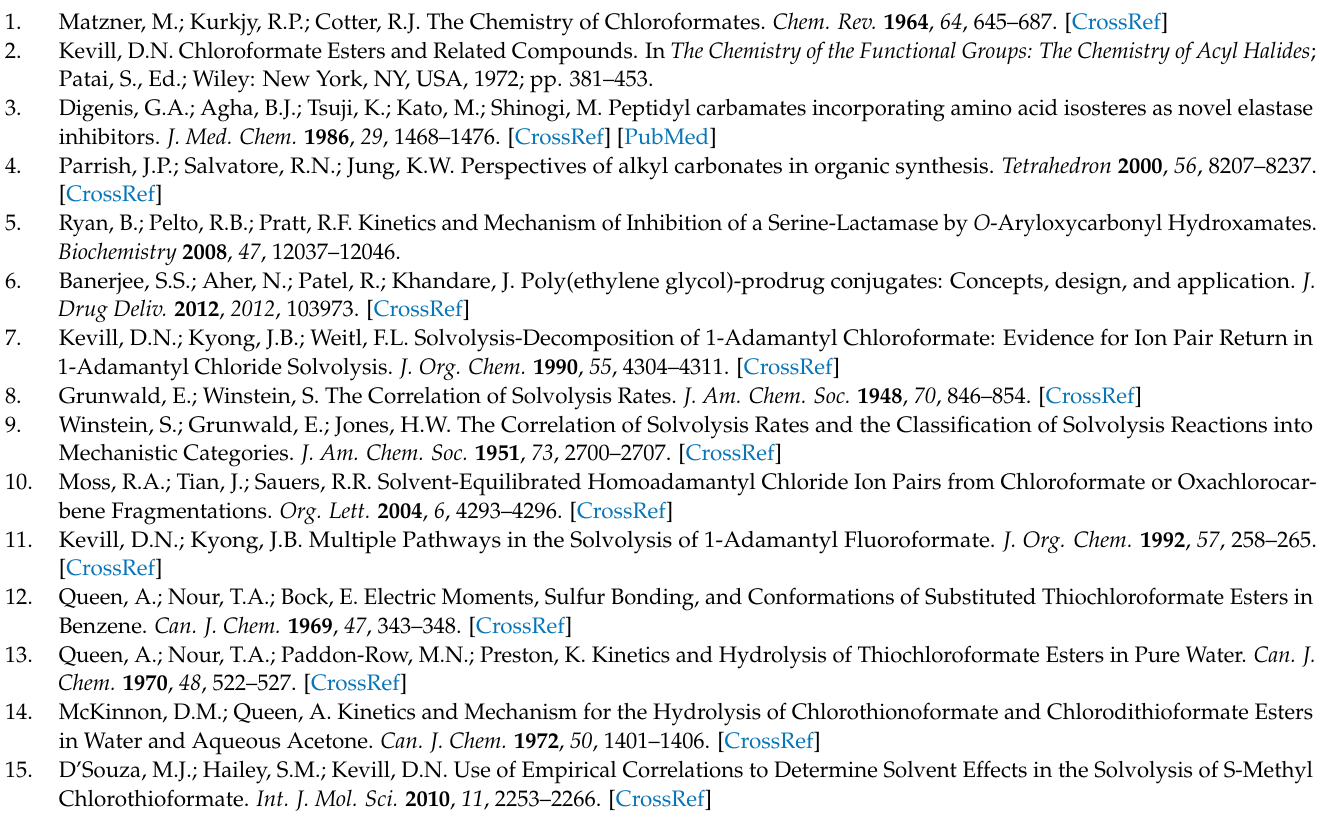
Figure S8: 13 C NMR spectrum of 1-adamantyl ethyl thiocarbonate, Figure S9: G.C. analysis sheet of 1-adamantyl ethyl thiocarbonate, Figure S10: IR spectrum of 1-adamantyl 2,2,2-trifluoroethyl thiocar- bonate showing characteristic C=O peak at 1708 cm − 1 , Figure S11: 1 H NMR spectrum of 1-adamantyl 2,2,2-trifluoroethyl thiocarbonate, Figure S12: 13 C NMR spectrum of 1-adamantyl 2,2,2-trifluoroethyl thiocarbonate, Figure S13: G.C. analysis sheet of 1-adamantyl 2,2,2-trifluoroethyl thiocarbonate, Figure S14: 1 H NMR spectrum of 1-adamantyl ethyl ether, Figure S15: 13 C NMR spectrum of 1- adamantyl ethyl ether, Figure S16: G.C. analysis sheet of 1-adamantyl ethyl ether, Figure S17: 1 H NMR spectrum of 1-adamantyl 2,2,2-trifluoroethyl ether, Figure S18: 13 C NMR spectrum of 1-adamantyl 2,2,2-trifluoroethyl ether, Figure S19: G.C. analysis sheet of 1-adamantyl 2,2,2-trifluoroethyl ether, Figure S20: G.C. analysis sheet of product of 1-adamantyl chlorothioformate solvolysis in 80% EtOH, Figure S21: G.C. analysis sheet of product of 1-adamantyl chlorothioformate solvolysis in 60% Me 2 CO, Figure S22: G.C. analysis sheet of product of 1-adamantyl chlorothioformate solvolysis in 70% TFE, Figure S23: G.C. analysis sheet of product of 1-adamantyl fluorothioformate solvolysis in 100% EtOH, Figure S24: G.C. analysis sheet of product of 1-adamantyl fluorothioformate solvolysis in60% EtOH, Figure S25: G.C. analysis sheet of product of 1-adamantyl fluorothioformate solvolysis in 70% TFE, Figure S26: G.C. analysis sheet of product of 1-adamantyl fluorothioformate solvolysis in